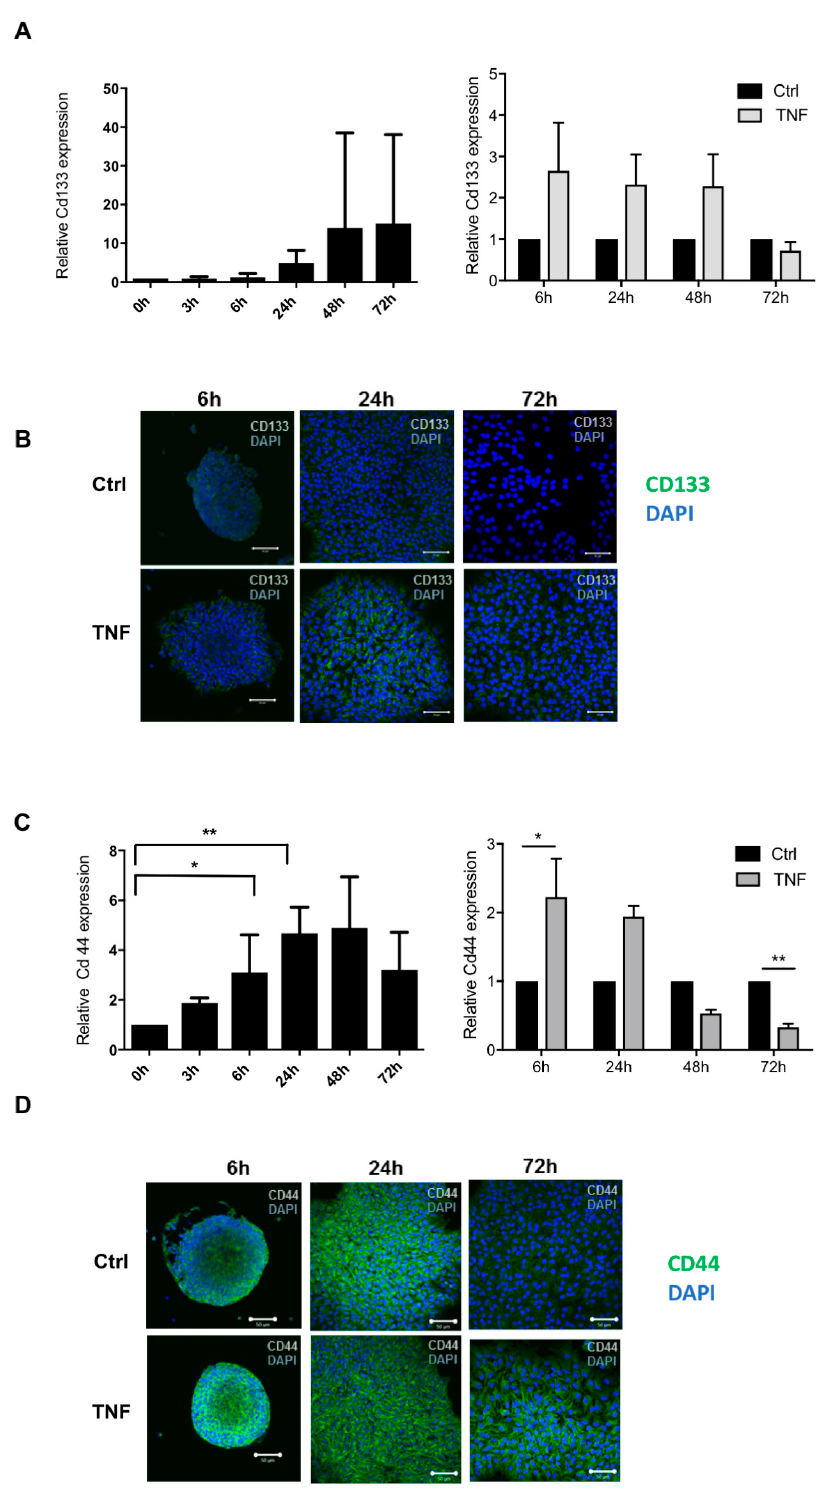
Figure 3. TNF tends to increase immaturity markers. Kinetic of Cd133 ( A ) and Cd44 ( C ) gene expression obtained by RT-PCR. Each time point is normalized to its 0 h of differentiation. ( A ) Effect of TNF treatment on Cd133 ( A ) and Cd44 ( C ) gene expression obtained by RT-PCR. Each time point is normalized to its FBS control (Ctrl = 1) * p < 0.05 and ** p < 0.01. Results are given as mean ± SEM ( n = 4). ( B ) Immunocytochemistry showing CD133 ( B ) and CD44 ( D ) protein expression (green) in TNF treated cells at 6, 24, and 72 h. Nuclei were counterstained with DAPI (blue). Scale bar: 50 µ